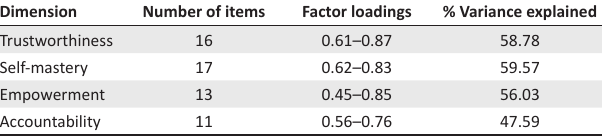
TABLE 2: Exploratory factor analysis output for the revised principled leadership scale